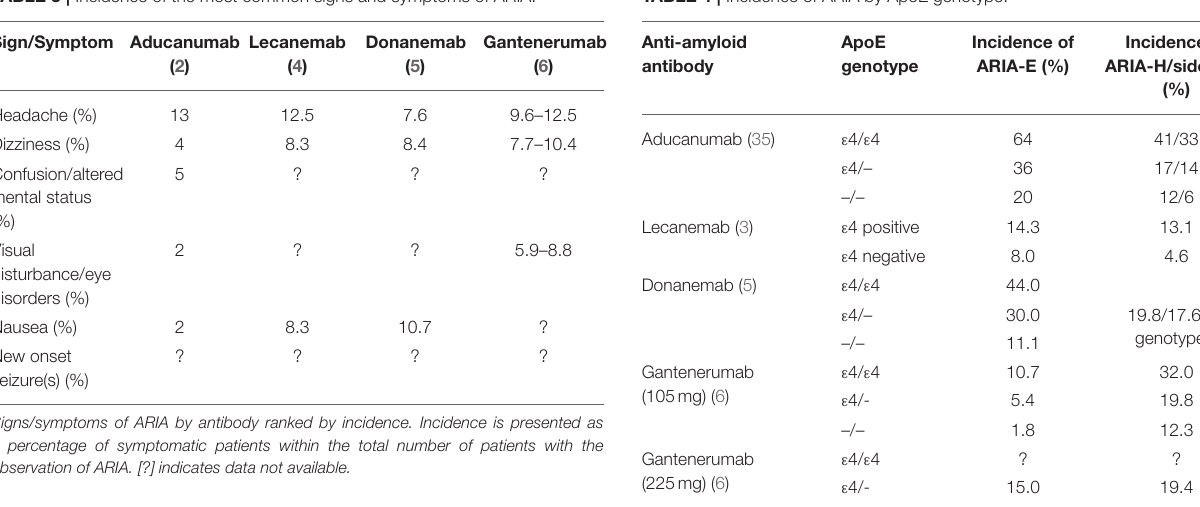
TABLE 4 | Incidence of ARIA by ApoE